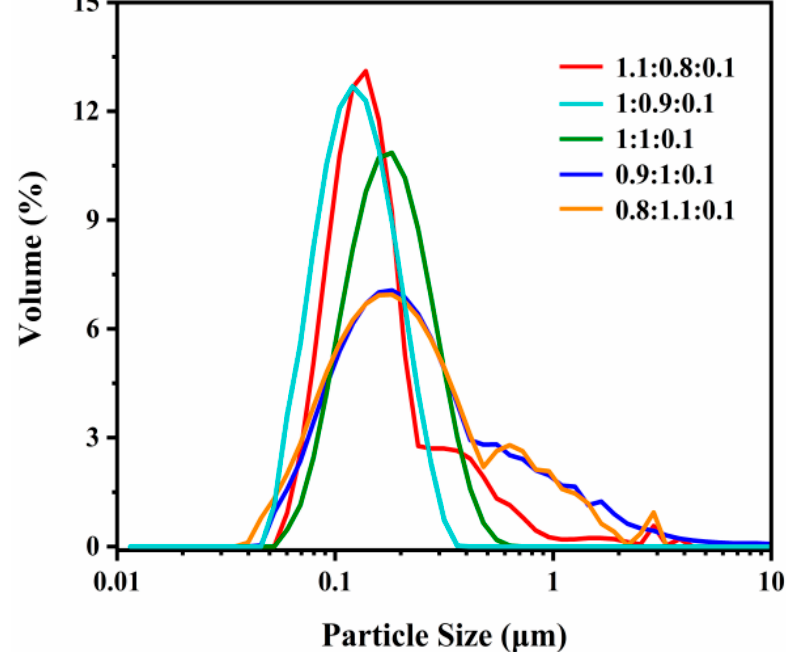
Figure 10. Particle size distribution at different monomer ratios (butyl acrylate (BA)/methyl acrylate (MMA)/acrylic acid (AA).